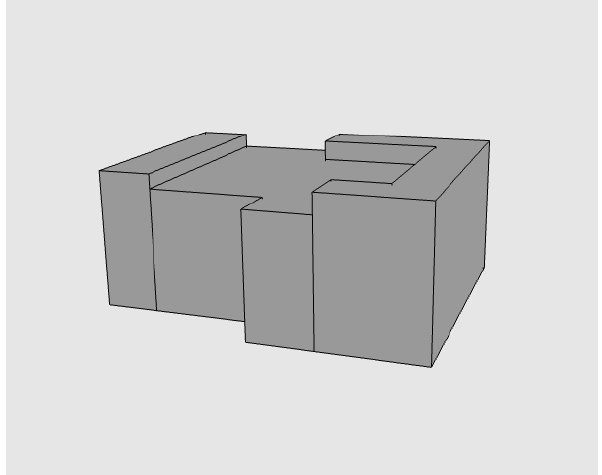
Figure 15. LOD2 CityGML 3.0 building model of Multihuset (cf. IFC model in Figure 13).